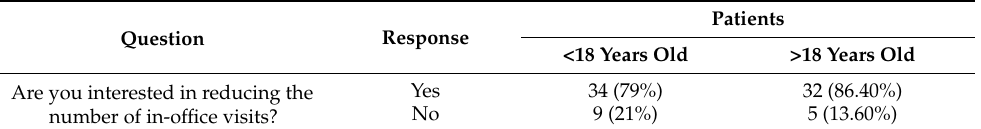
Table 3. Association between age and interest in reducing the number of in-office visits among the patients.